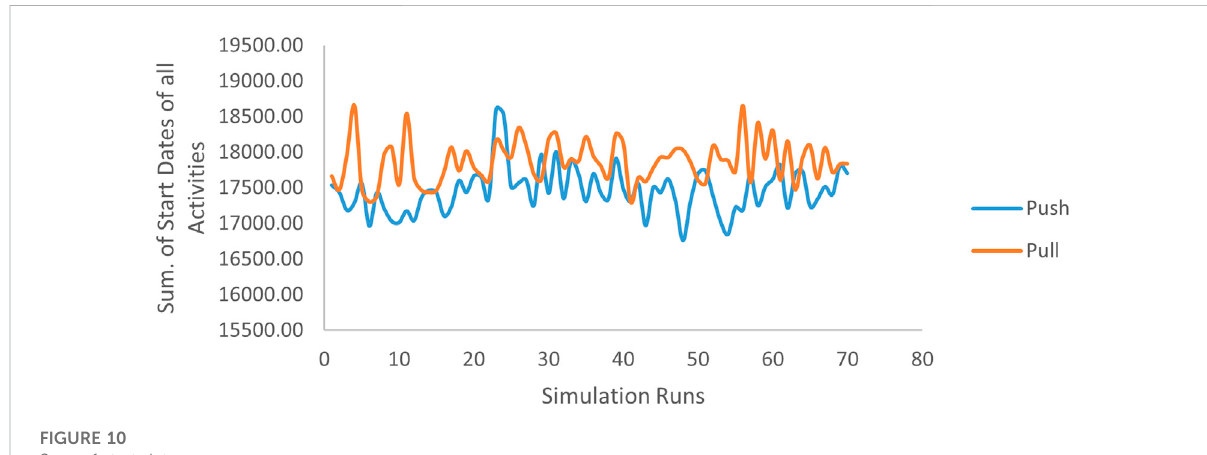
FIGURE 10 Sum of start dates.